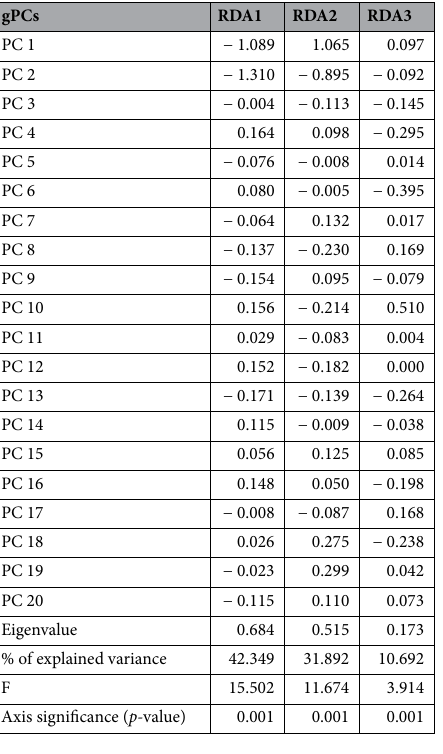
Table 3. Results of partial redundance analysis (RDA) performed to evaluate the association between the pattern of mitochondrial genetic structure of Abrothrix olivacea and the climatic variability of its geographic distribution. The loadings of the 20 first principal component (gPCs) obtained from the genetic based PCA on the three first RDA axes are presented. In addition, the eigenvalue, explained variance, F value and the significance ( p- value) of each RDA axis is